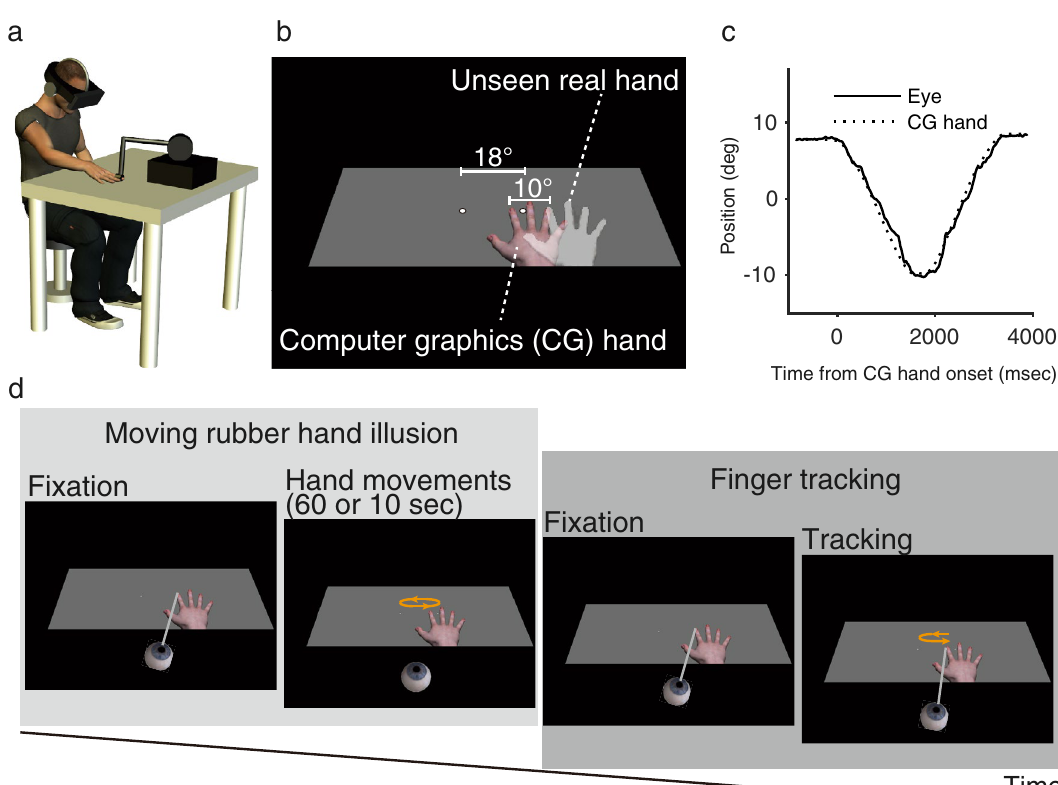
Figure 1. Apparatus, stimuli, and procedure. ( a ) Participants binocularly viewed the visual stimulus presented through a head-mounted display and placed their right hand on a table. Their right index finger was attached to the arm of a force-feedback device. ( b ) A computer graphics (CG) hand and two white points were presented on a gray surface in the virtual environment. The right index finger of the CG hand was placed 10° to the left of the participant’s unseen right index finger. One white point served as the starting point of eye and hand movements, and the other served as the turning point. ( c ) Sample result of eye and hand positions for one participant. ( d ) On a given trial, the participant’s hand was moved actively or passively to induce the moving rubber hand illusion. Then, the participants were instructed to track the CG hand movements with pursuit eye movements.